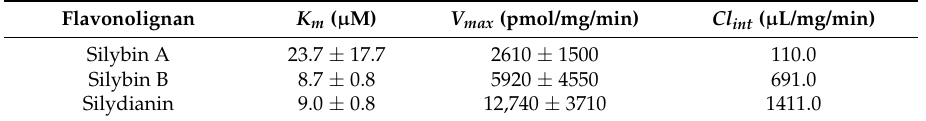
Table 1. UDP-Glucuronosyltransferase 1A1 Michaelis–Menten kinetic parameters for flavonolignans by substrate depletion method.